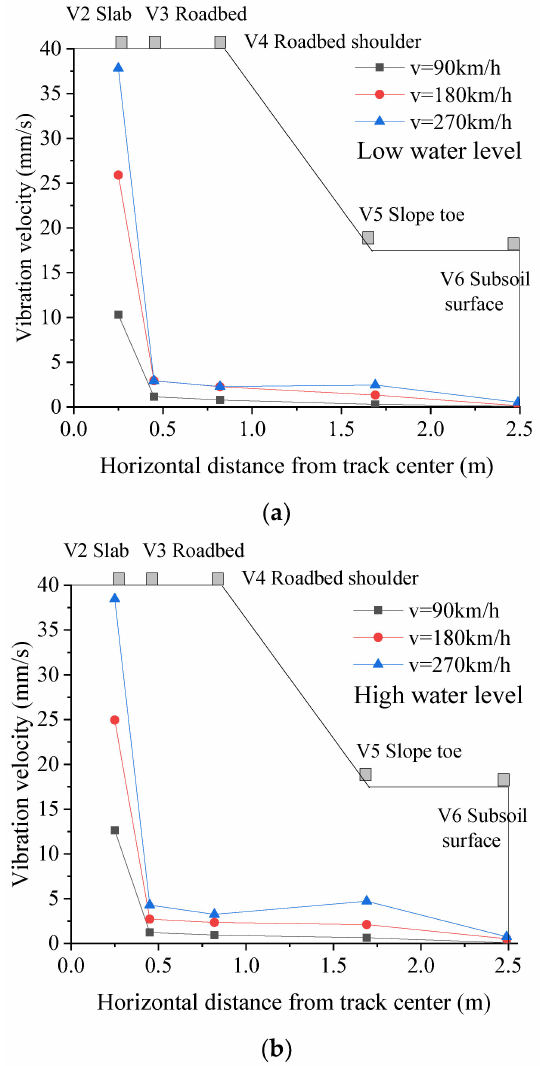
Figure 13. Vibration velocity distribution in horizontal direction from the track center. ( a ) low water level, ( b ) high water